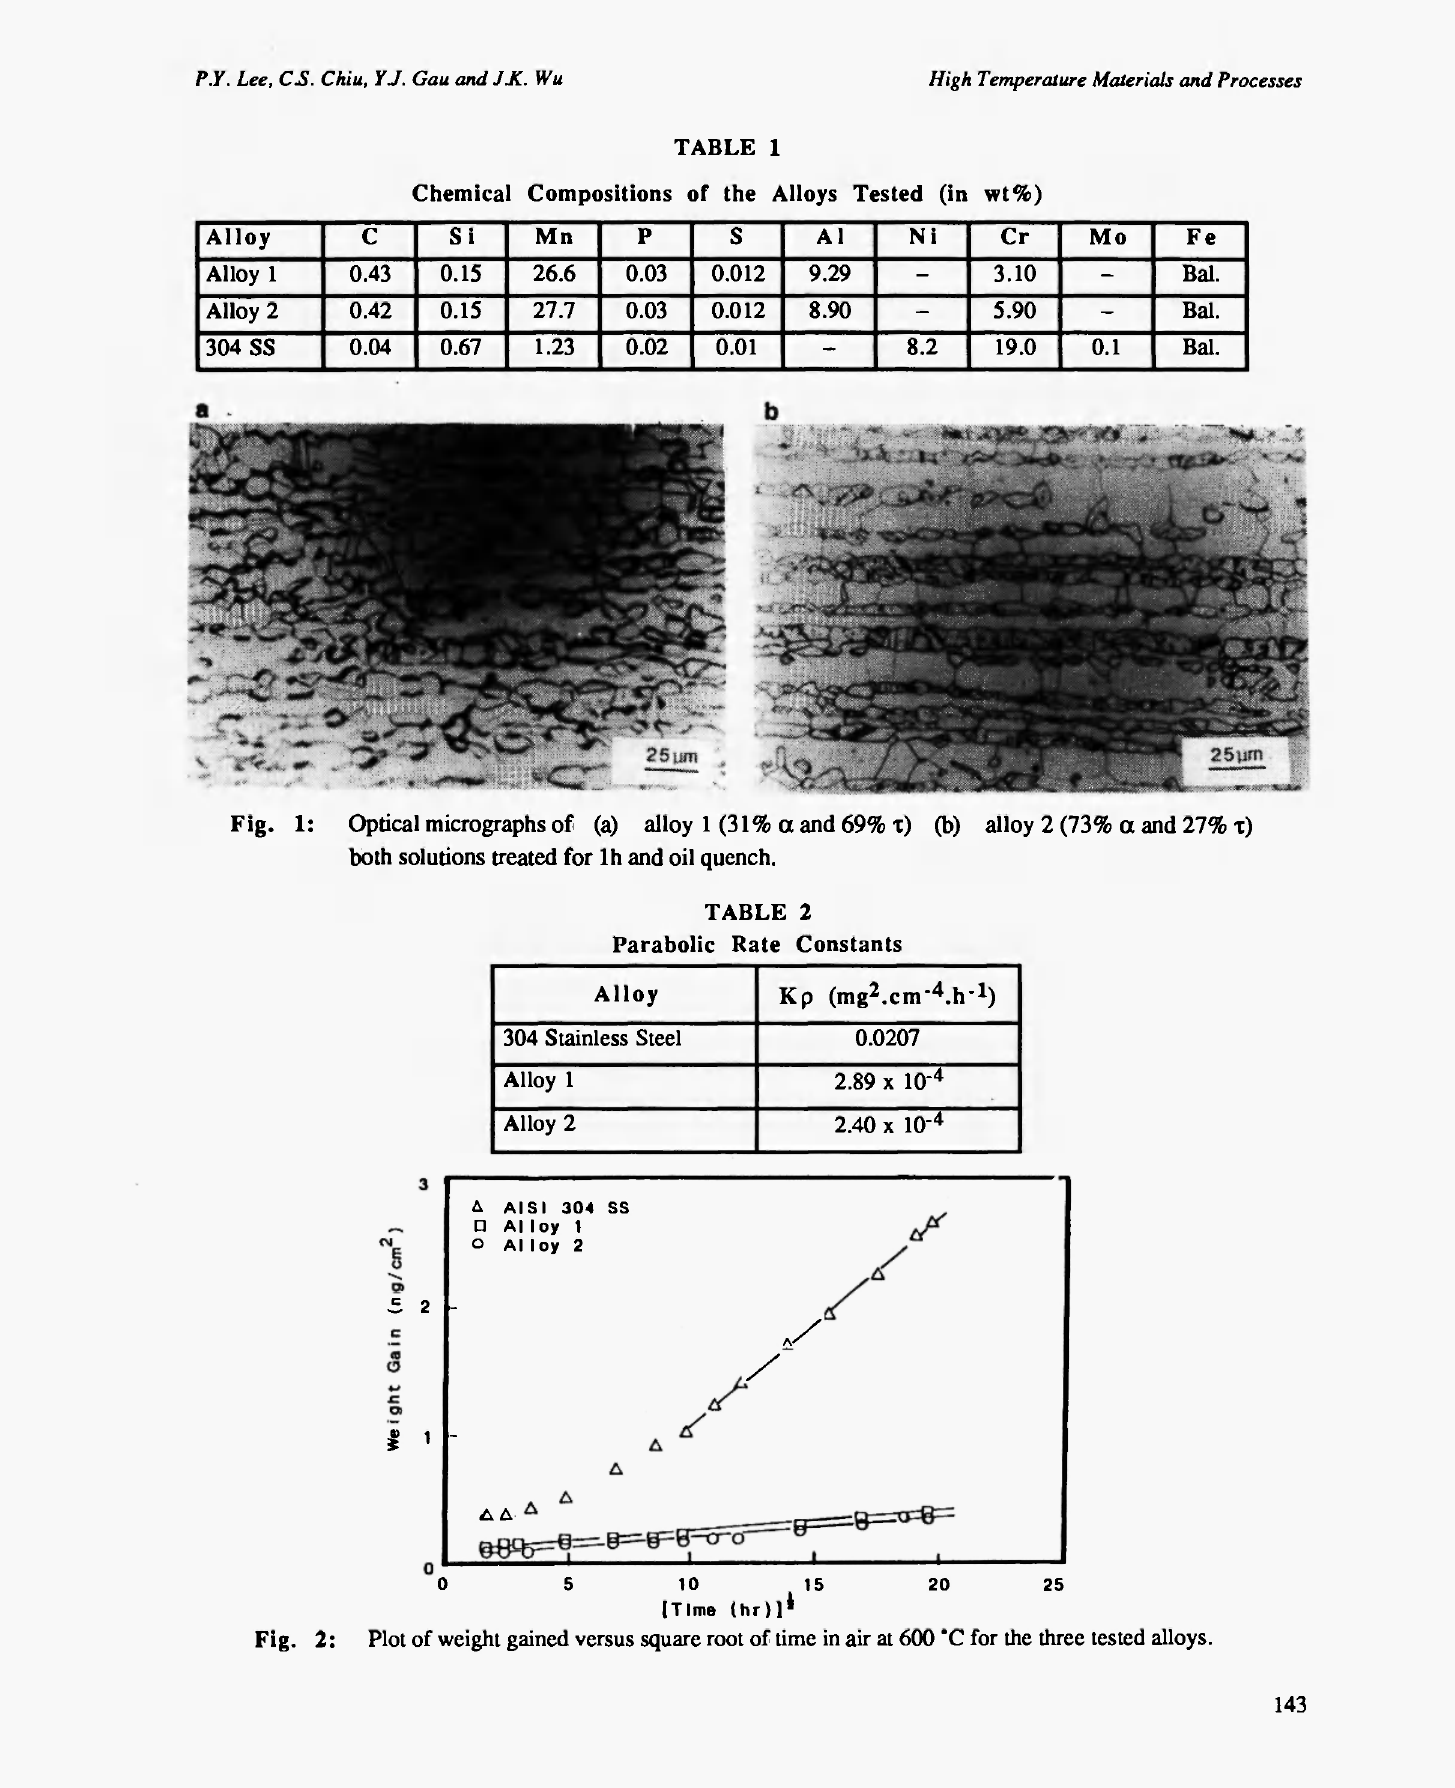
IΤ line (hr)l* Plot of weight gained versus square root of time in air at 600 "C for the three tested Fig. 2: